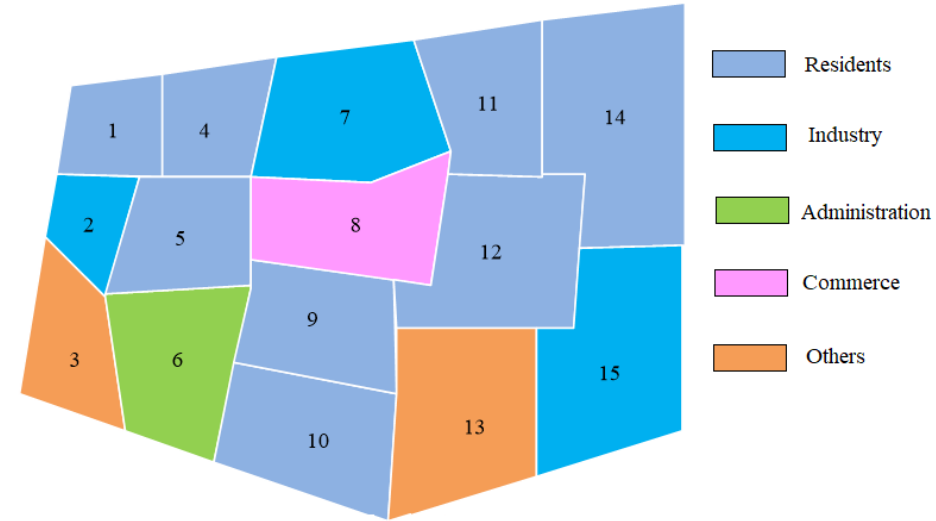
Figure 7. The result of detailed division of decision area.